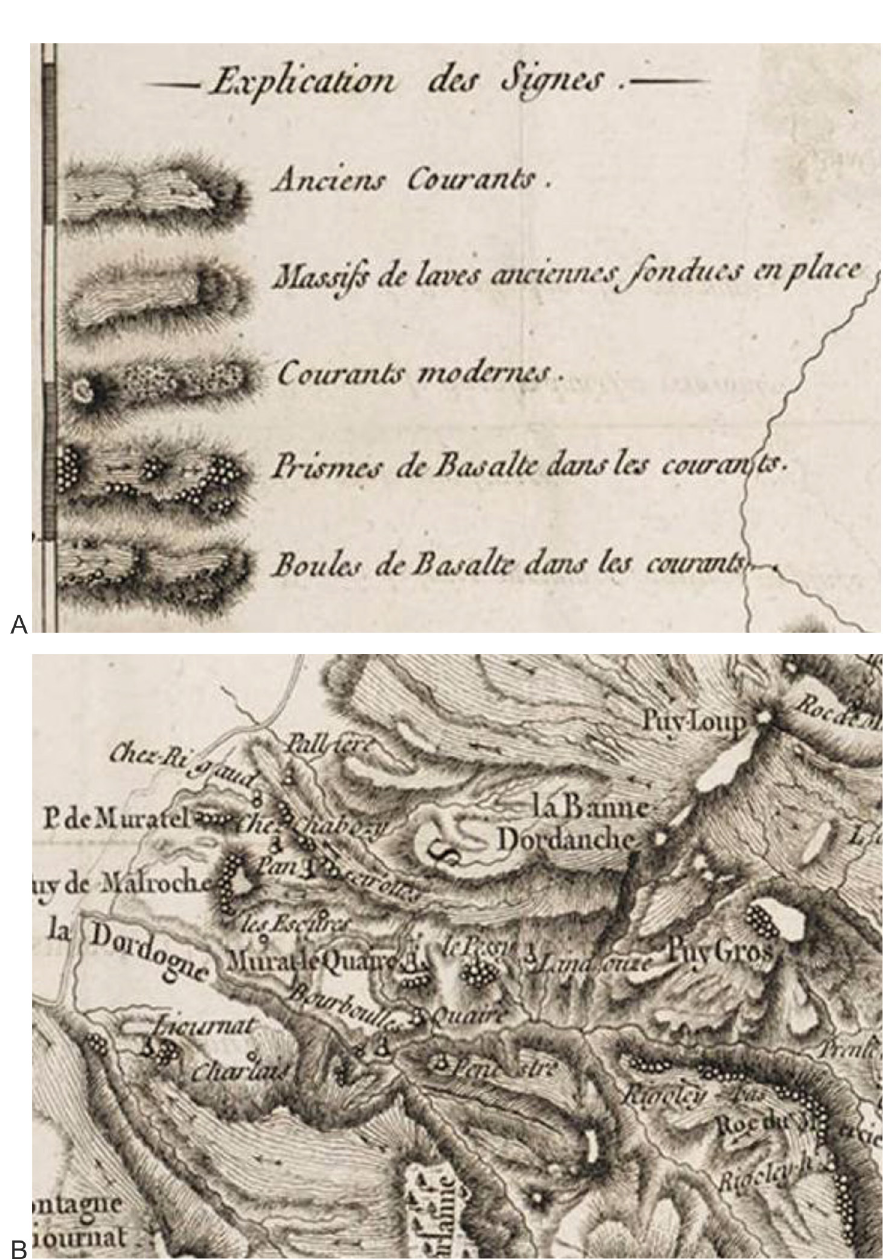
Fig. 1. The explanation – A, and a part – B of the map titled Carte d’une partie de l’Auvergne , created by Nicolas Desmarest at a scale of approx. 1:130,000; the explanation contains five categories: (1) directions of lava flows, (2) former lava fields, (3) directions of later lava flows, (4) basalt columns together with their flow directions, (5) basalt pillows together with their flow directions (from the collection of Bibliothèque nationale de